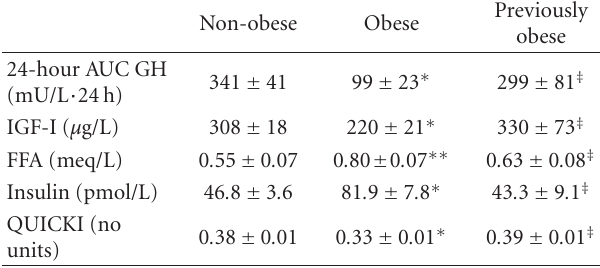
Table 1: Twenty-four-hour GH, basal levels of insulin, FFA, IGF-I levels, and insulin sensitivity in 16 obese, 8 previously obese, and 16 non-obese.